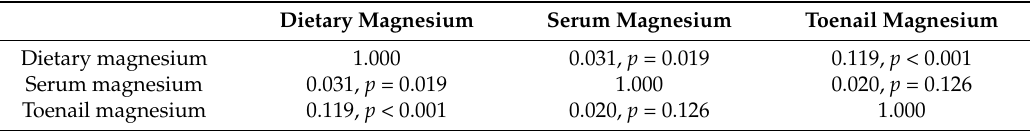
Table 5. Correlations of dietary magnesium, serum magnesium, and toenail